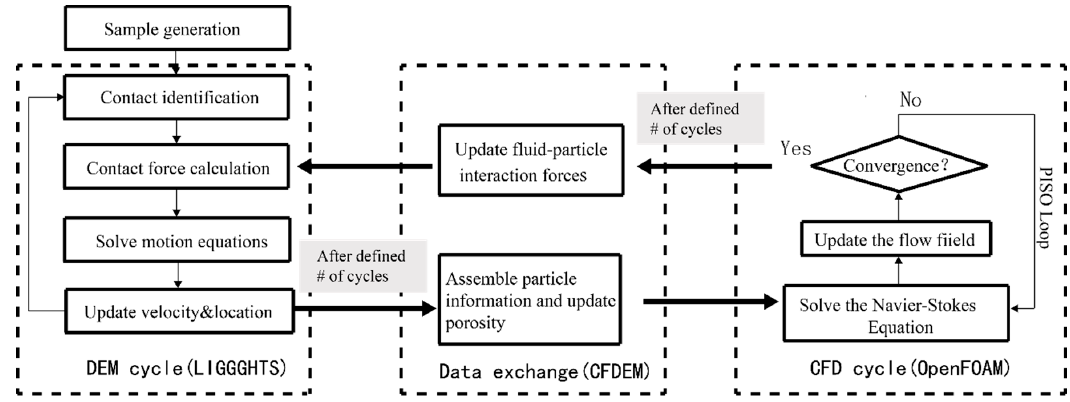
Figure 3. Coupling process of computational fluid dynamics (CFD)–discrete element method (DEM) (adapted from [10]).